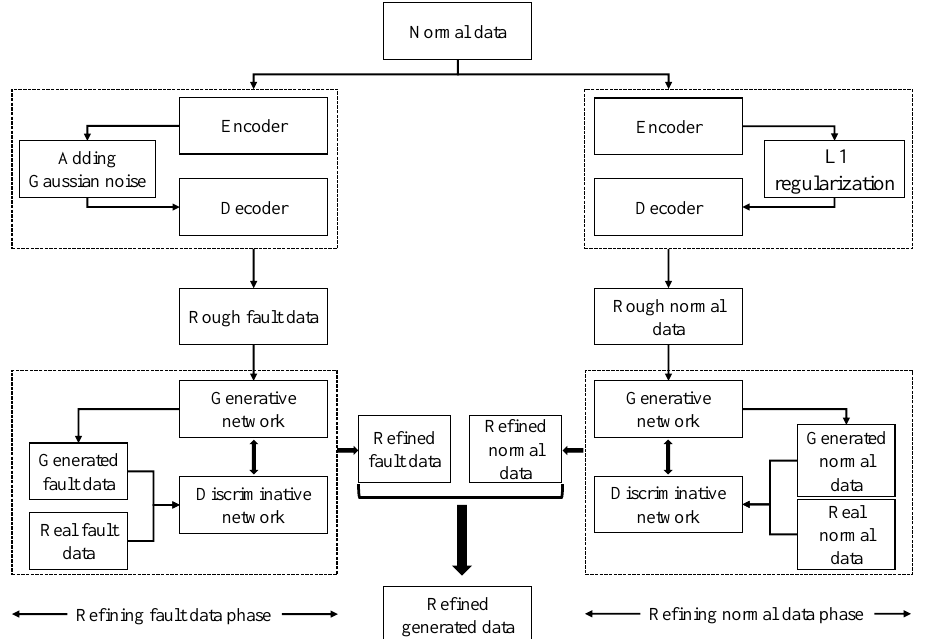
Figure 5. Flowchart of DCGAN-based data augmentation.